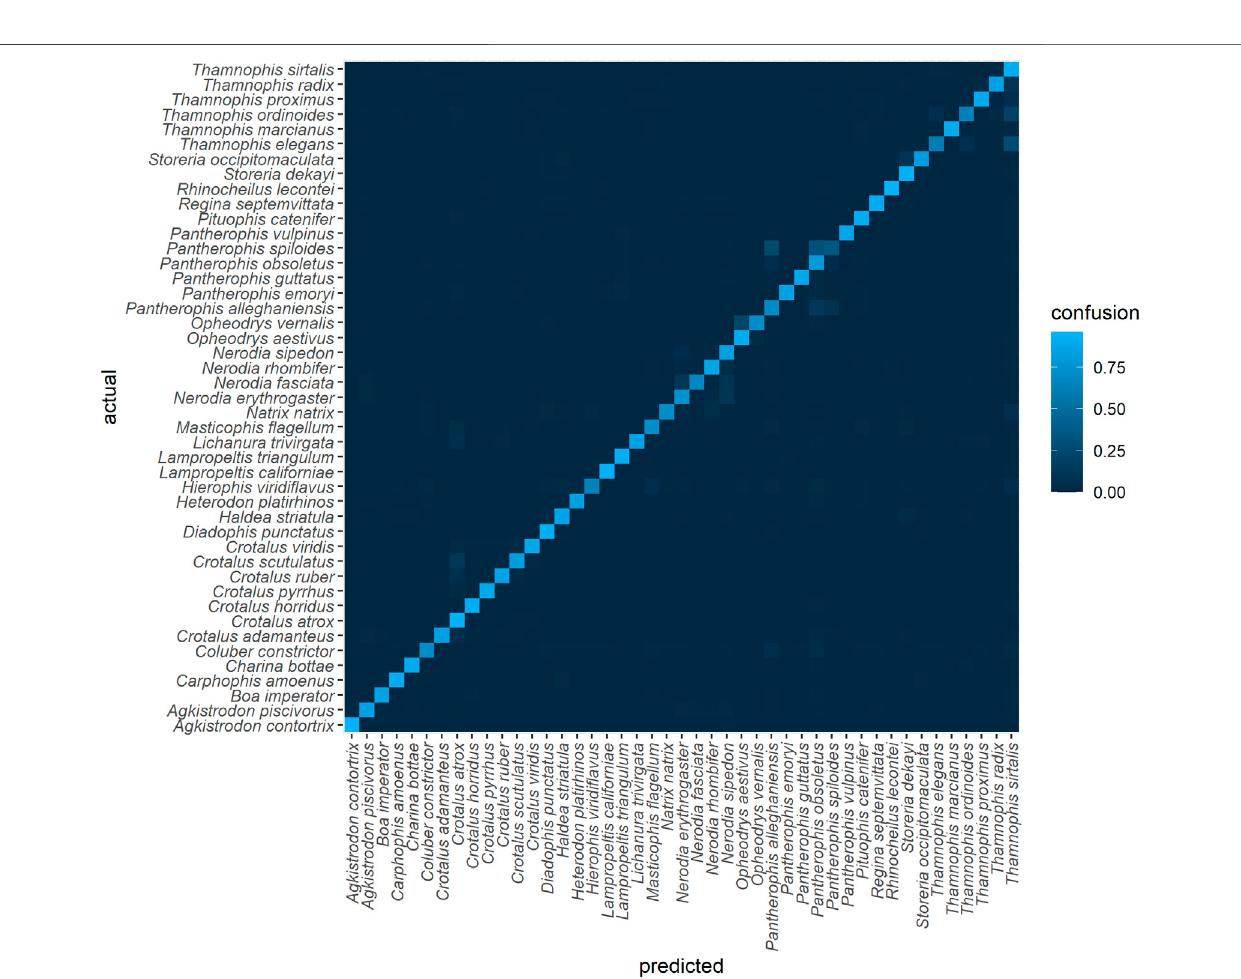
FIGURE 5 | Confusion matrix for the top algorithm, using TD1 and an 80-20 split (subset of training data). The fi nal model was trained on a 95-5 split. For an interactive version see https://chart-studio.plotly.com/~amdurso/1/#/.